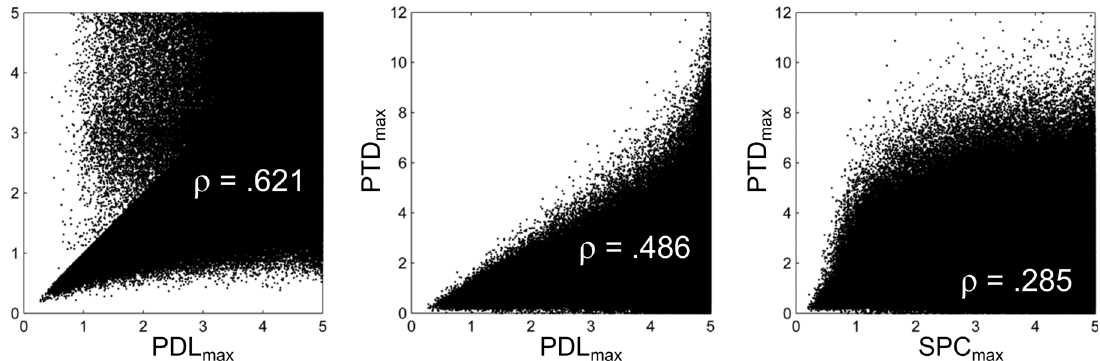
Figure 5. Pairwise scatter plot relationships (with associated Spearman correlation r values) for three BEATS Summary Statistics that quantify the stability of an IBeI series: PDL max , SPC max , and PTD max .